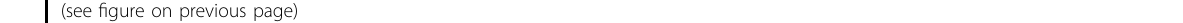
Fig. 5 BCL-B inhibits mitophagy and apoptosis in HSCs. a Mitochondrial DNA (mtDNA) measured by PicoGreen staining in LX2 cells; scale bar, 10 μ m. b Representative western blots of TOM20 and BCL-B. Bar graph represents the mean ± SEM of three different experiments. * P < 0.05 and ** P < 0.01 vs. the indicated groups. c TUNEL staining of LX2 cells; scale bar, 25 μ m. Bar graph represents the mean ± SEM. * P < 0.05 vs. the indicated groups. d Representative western blots of cleaved caspase3, cleaved caspase9, collagen I and α -SMA in LX2 cells. Bar graph represents the mean ± SEM of three different experiments. * P < 0.05 and ** P < 0.01 vs. the indicated